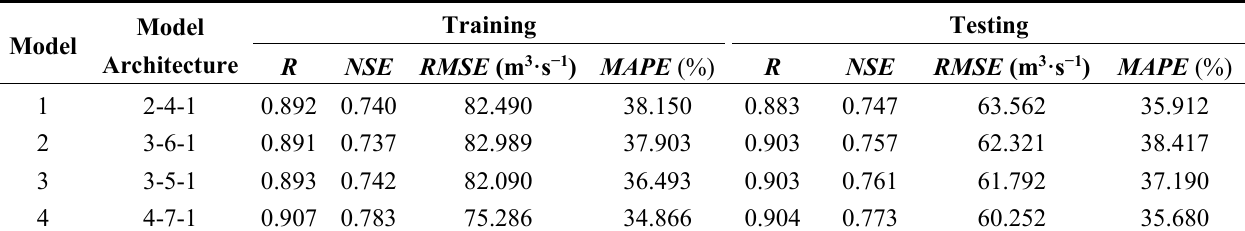
Figure 4. Performance of model 1 against different numbers of nodes in hidden layer. Table 2. Architectures and indices of various ANN forecasting models for Hongjiadu